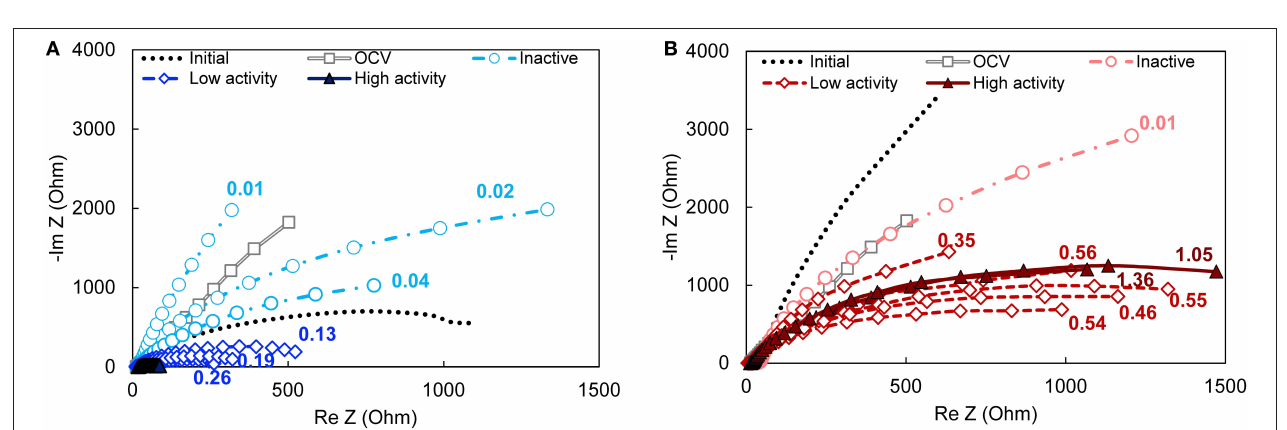
FIGURE 2 | Cyclic voltammograms (CVs) taken at the end of the startup period for bioanodes fixed at (A) E AN = − 0.15V and (B) E AN = + 0.15V. All curves in the same plot are replicates. High-, low-activity, and inactive bioanode levels are defined based on the time required to reach the startup current threshold ( Figure 1 ). Numbers next to each curve represent the current density recorded at the end of the startup cycle. E 1 / 2 , midpoint potential (vertical black dashed line); i p , peak current obtained during the potential sweep; OCV, open circuit voltage (dotted black line).